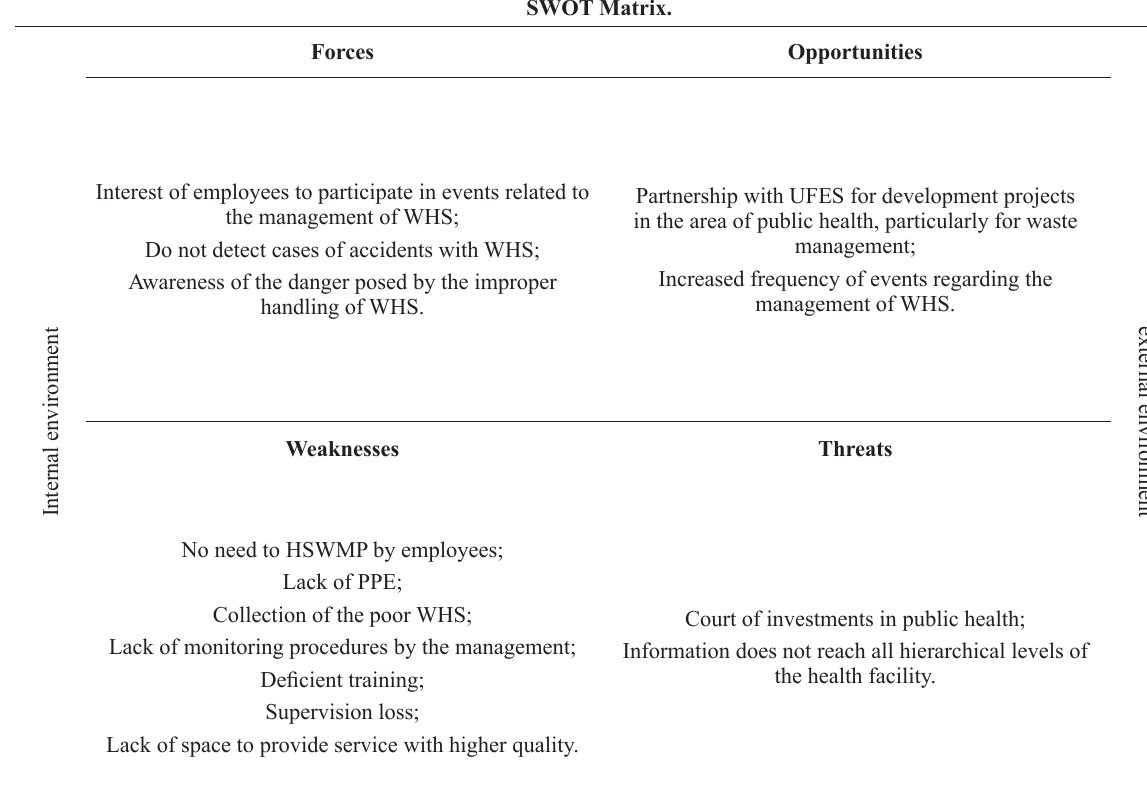
Figure 4 - Dendrogram for